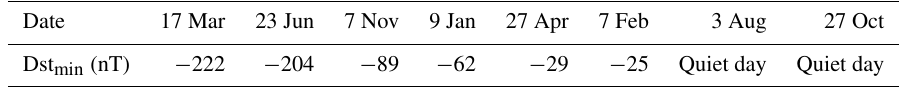
Table 1. Dst index of the events in 2015.